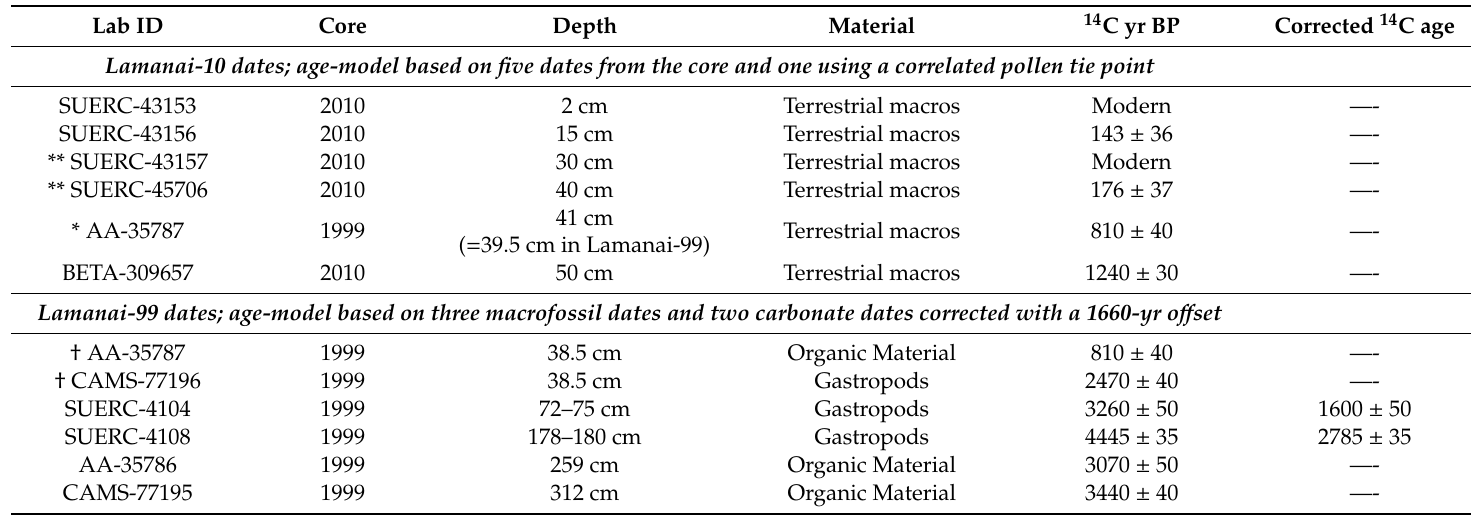
Table 2. Radiocarbon dates, hardwater o ff set, and the pollen tie-point * used to create the two independent age models using Bayesian modelling. ** denotes rejected dates. † indicates the paired dates (organic material and gastropods) for which the 1660-year hardwater o ff set was calculated. ‘Terrestrial macrofossils’ refer to samples that contained identifiable plant remains recovered from Lamanai-10, whereas Lamanai-99 was dated with undi ff erentiated ‘organic